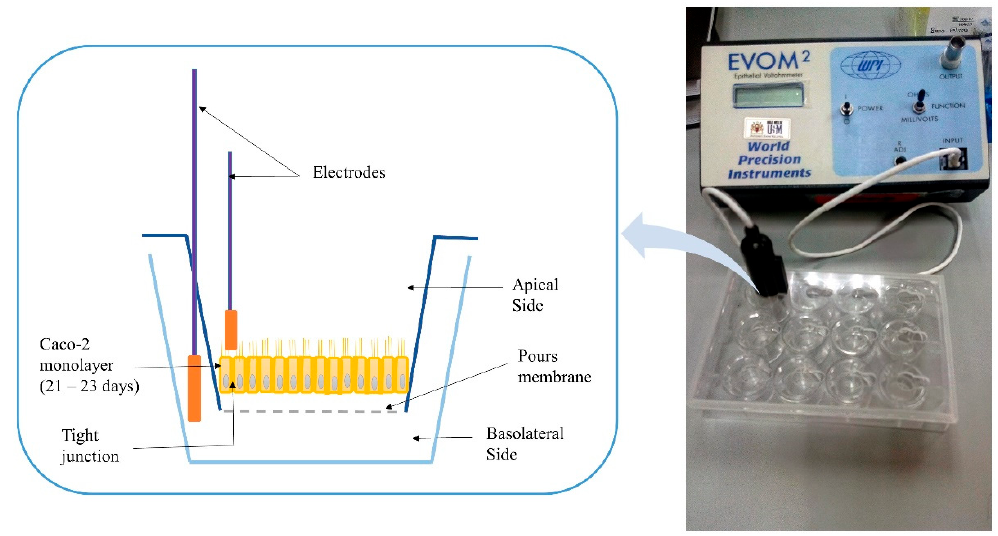
Figure 1. Schematic diagram for the measuring procedure of transepithelial electrical resistance